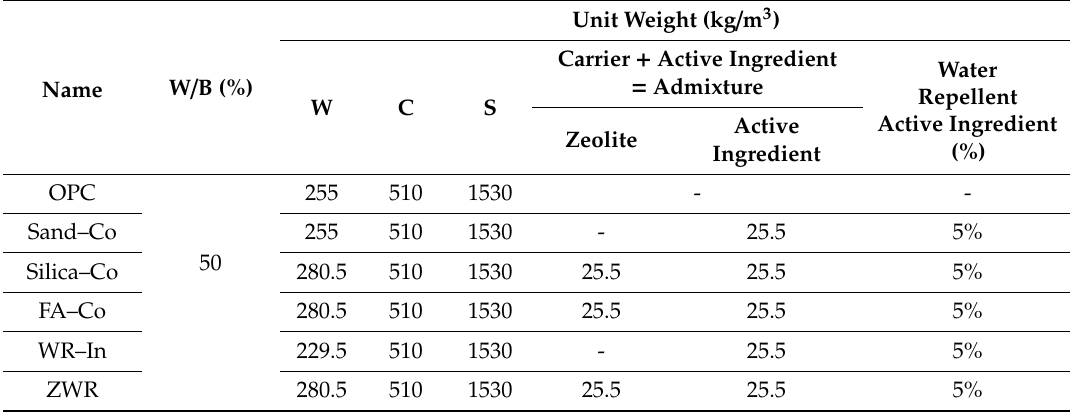
Table 6. Cement mortar mix proportion.